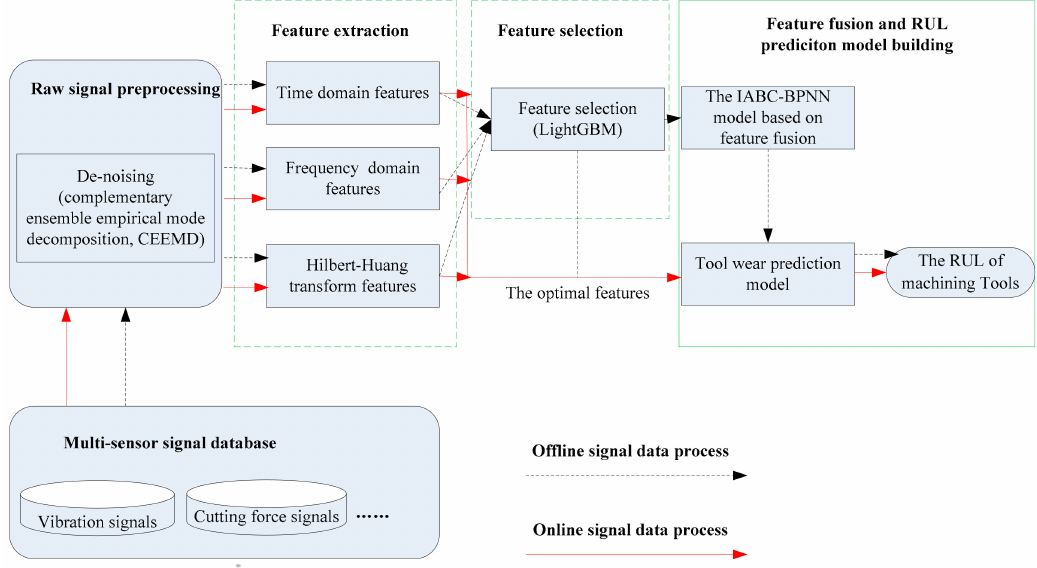
Figure 1. A remaining useful life (RUL) prediction system of machining tools based on multi-sensor data